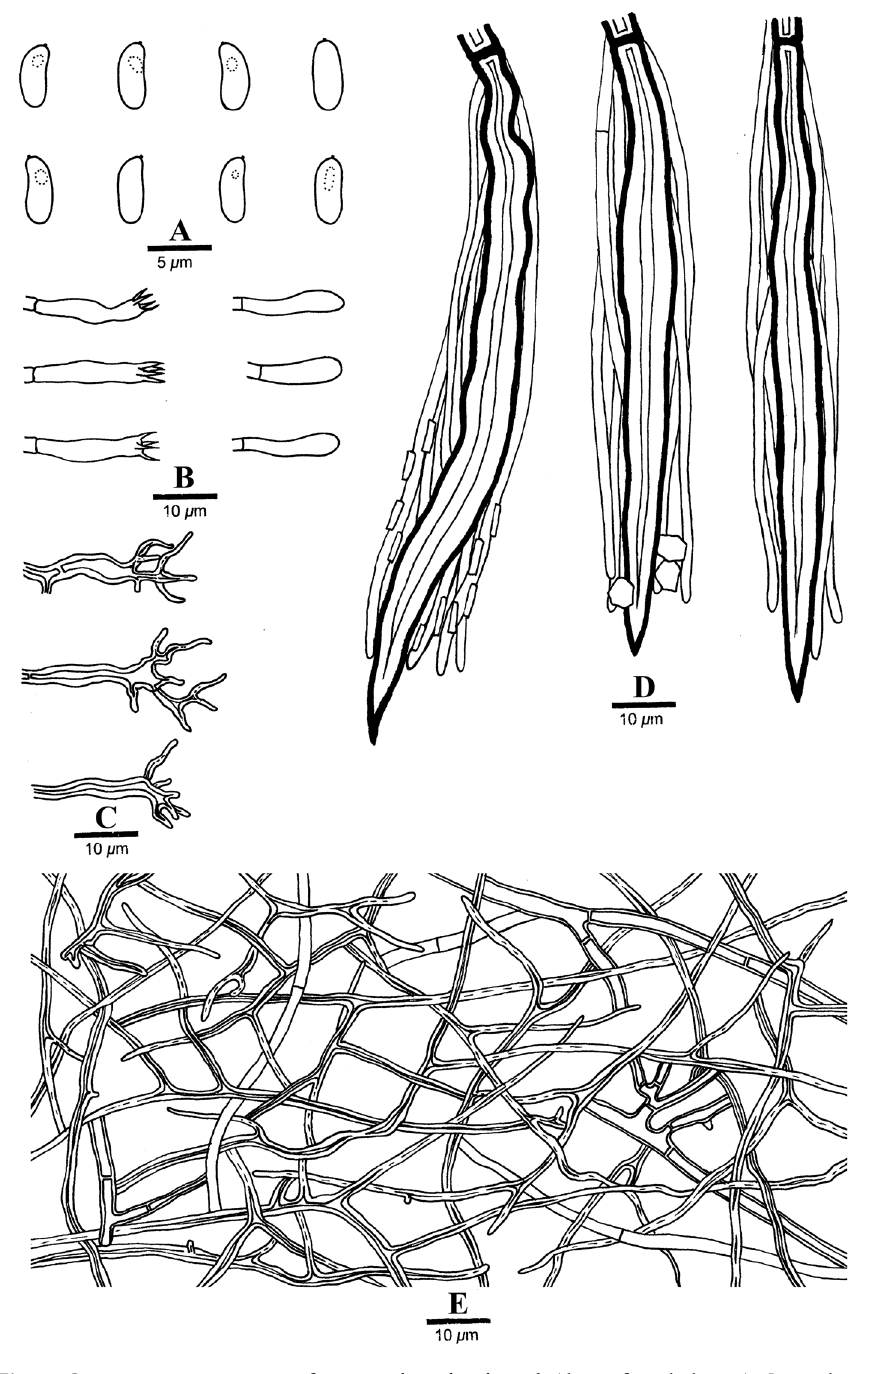
Figure 3. Microscopic structures of Hymenochaete bambusicola (drawn from holotype). A Basidiospores B Basidia and basidioles C Dendrohyphidia D Setae E Hyphae from hyphal